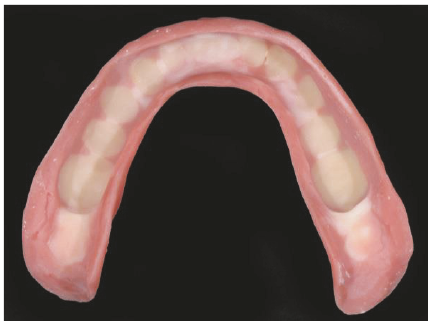
Figure 6: The lower denture was emptied internally, in order to subsequentially accommodate inside the future intraorally welded titanium framework. The flanges and the supports in the retromolar areas were preserved, in order to facilitate the positioning in the postwelding phase.